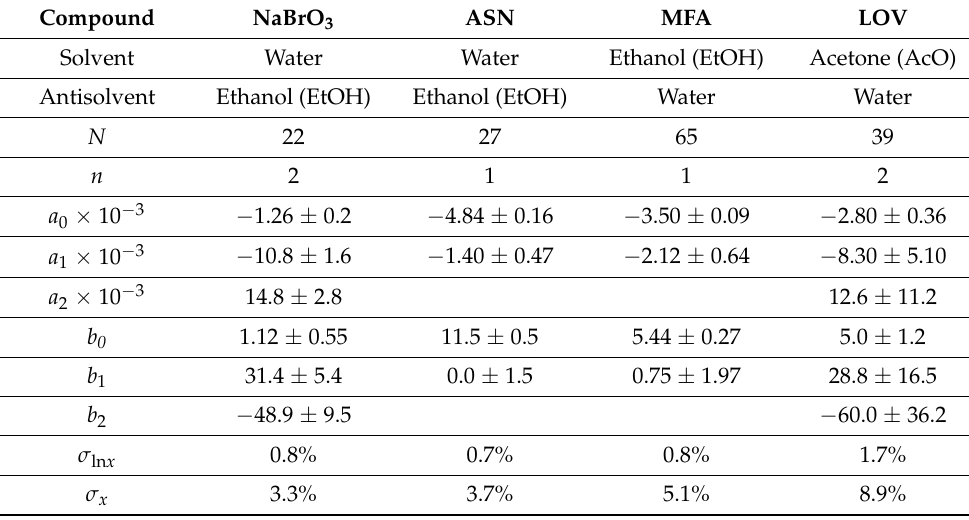
Table 1. Fitting parameters and their standard errors obtained from the model Equation (3) using the entire dataset for a combination of compound, solvent and antisolvent. The relative standard deviations σ ln x and σ x from Equation (4) for each system are also